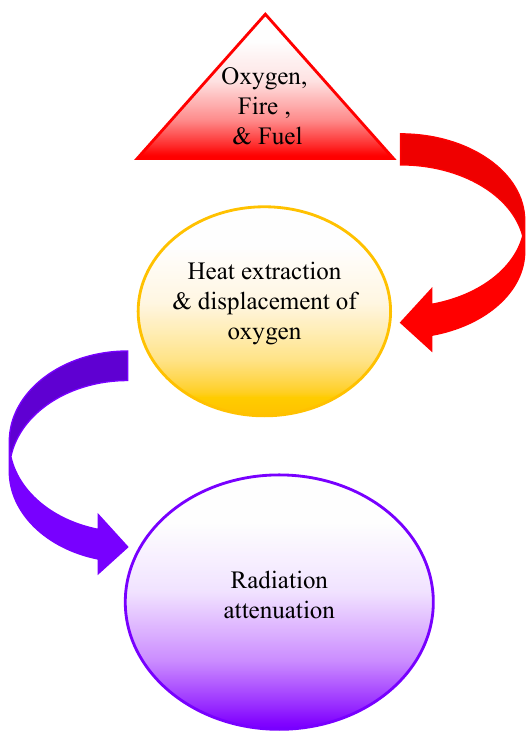
Figure 3. Fire suppression mechanism of water mist.